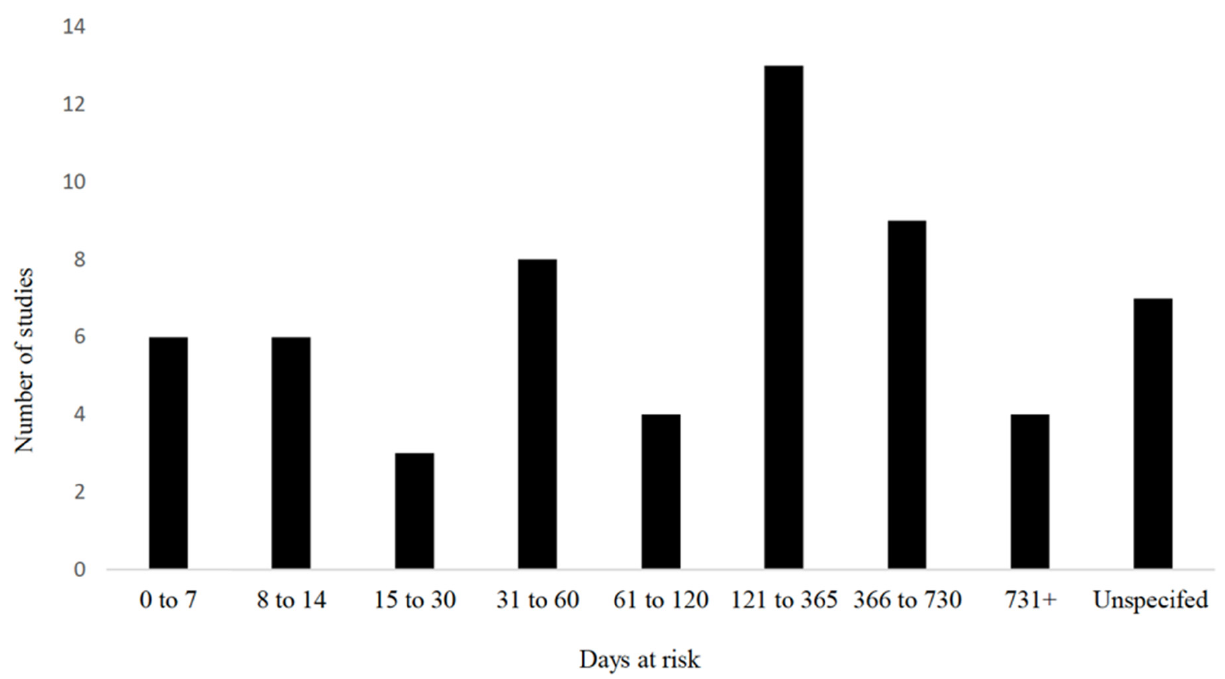
Figure 4. Time at risk (days) for development of outcomes in observational studies examining risk factors for umbilical health ( n = 60) included in the scoping review of literature surrounding umbilical health in intensively raised bovines.